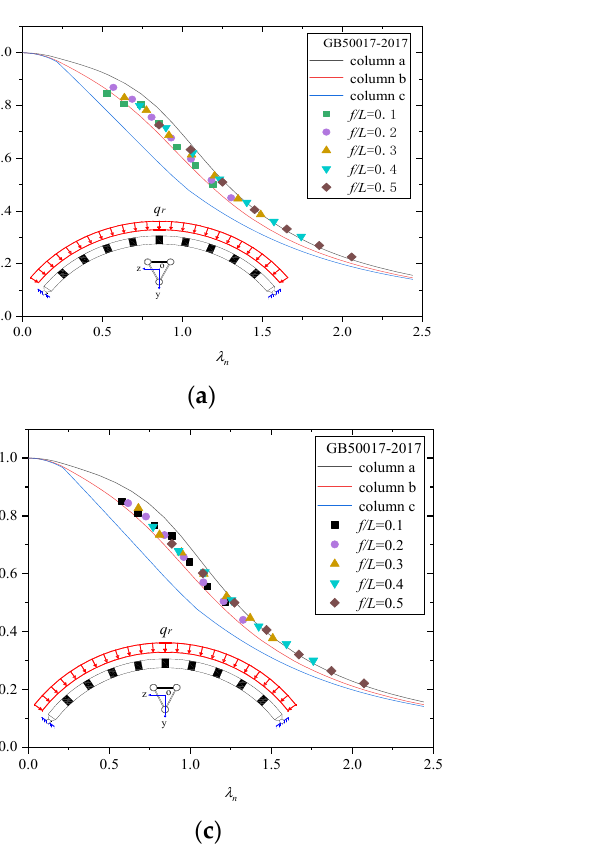
( c ) Figure 14. Internal force distribution along the arch axis under FSUVL ( (cid:3033) (cid:3013) = 0.3): ( a ) axial force; ( b ) bending moment; ( c ) shear force.